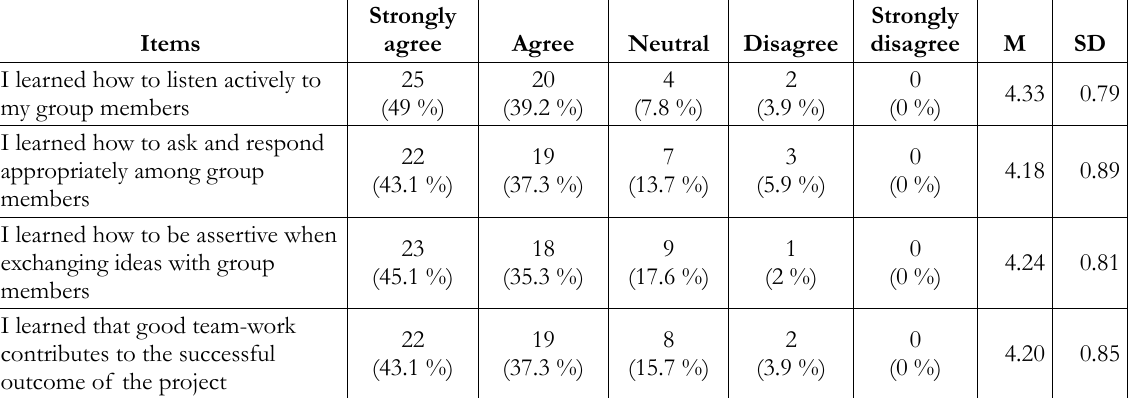
Table 4. The data analysis of students’ perceptions of teamwork